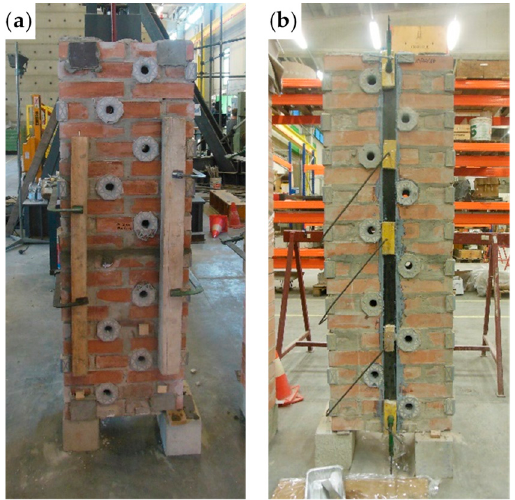
Figure 40. Modes of fracture.